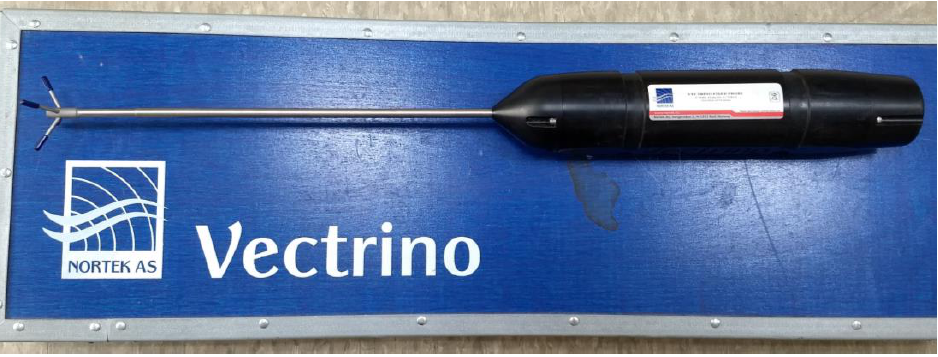
Figure 5. The acoustic Doppler velocimeter for the validation of the PIV-analyzed velocity field.